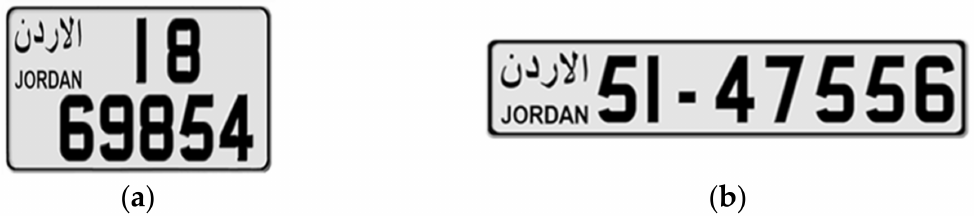
Figure 1. Examples of Jordanian license plates for private vehicles. ( a ) American standard (34 × 22 cm). ( b ) European standard (52 × 11.4 cm).